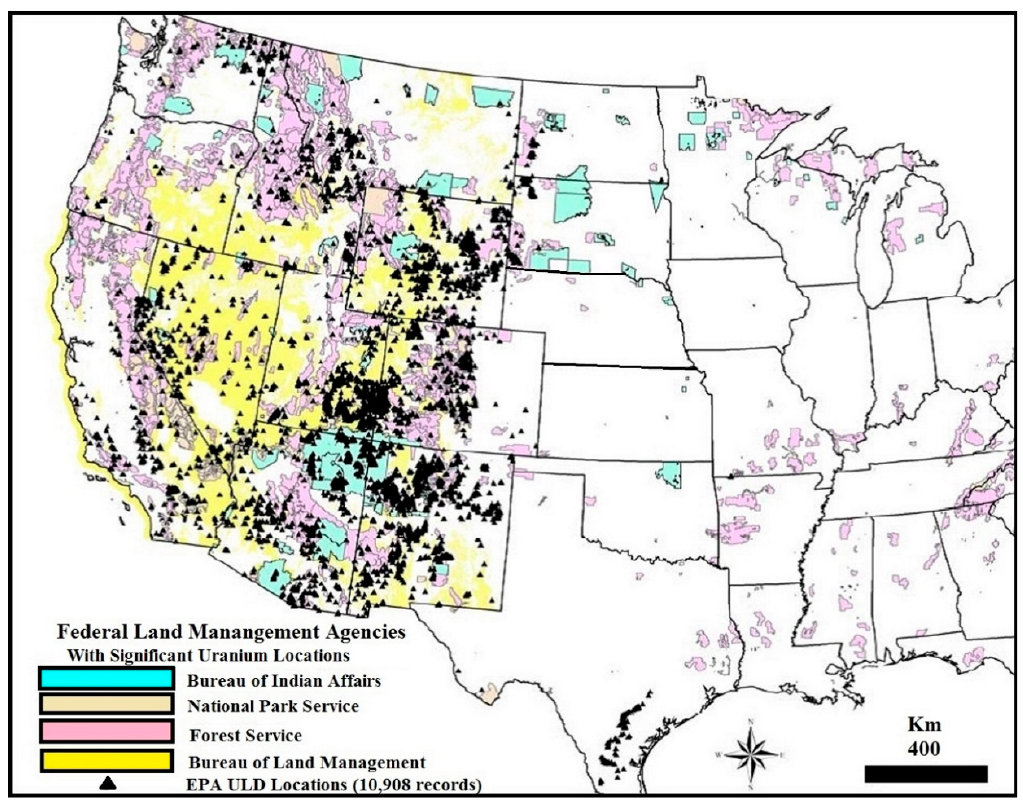
Figure 1. Uranium locations from Environmental Protection Agency (EPA) database and Federal Lands. The green federal lands are Native American reservations. About three-fourths of the uranium locations in the EPA Uranium Location Database are on Federal